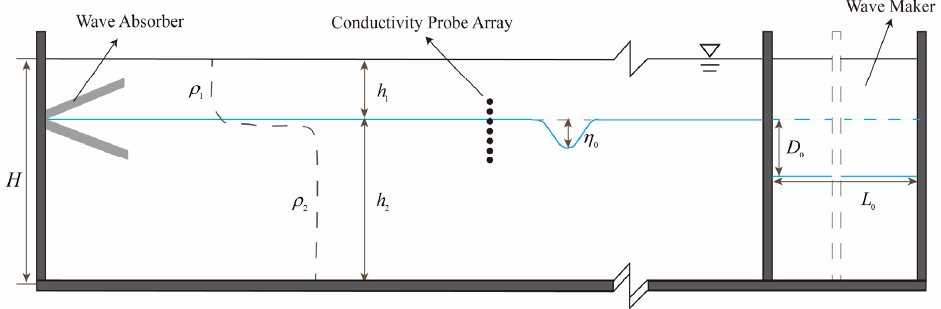
Figure 1. Schematic diagram of the experimental apparatus.